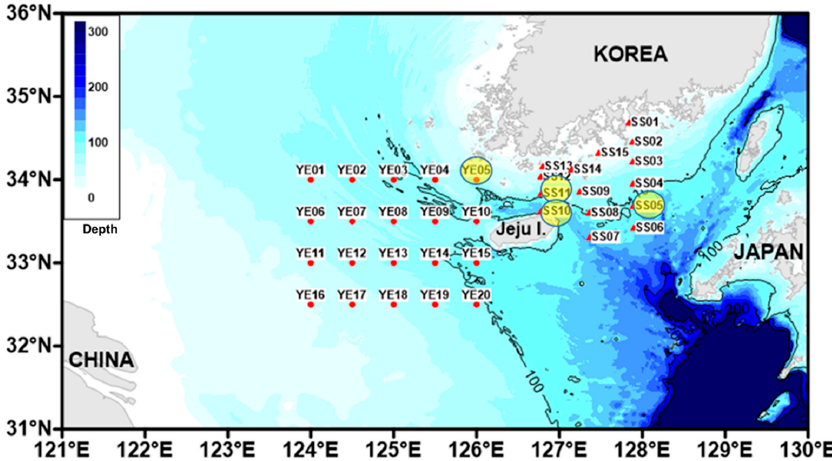
Figure 1. Map of the study area. The red dots indicate the collection sites, and the yellow circles are the areas where samples were obtained. Table 1. List of species names examined in this study, as well as their GenBank accession numbers, collection sites, and associated references.